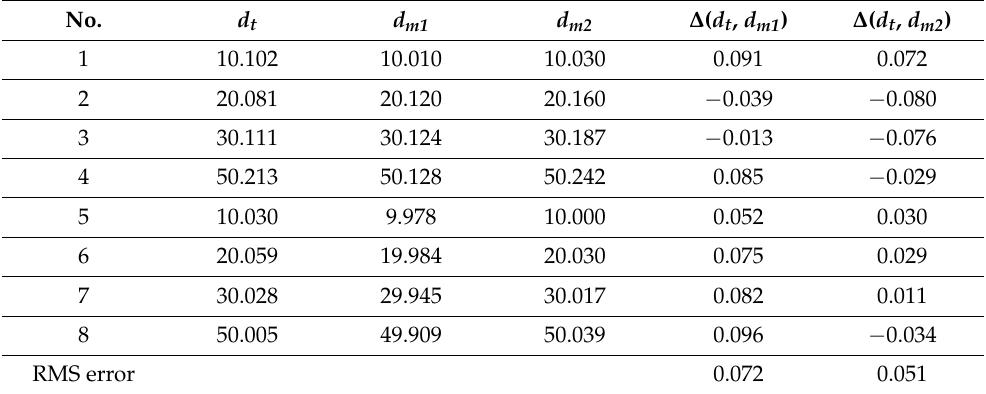
Table 2. Statistical results computed by Zhou’s method and the method proposed in this study. (Unit: